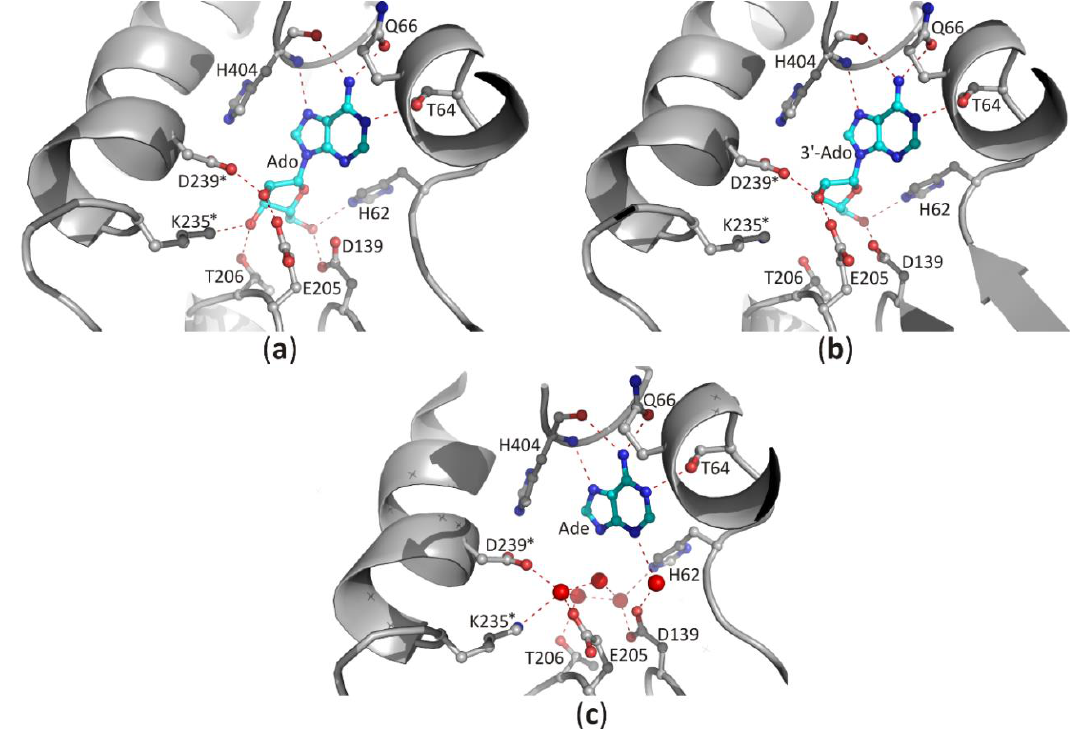
Figure 5. The binding mode of ligands present in the SBD domain of plant SAHase from Lupinus luteus : ( a ) adenosine (Ado), ( b ) 3′-deoxyadenosine (3′-dAdo), and ( c ) 2′-deoxyadenosine [26]. The potential polar interactions are marked with red dashed lines. Residues from the CBD domain are marked with stars. Water molecules are shown as red spheres.